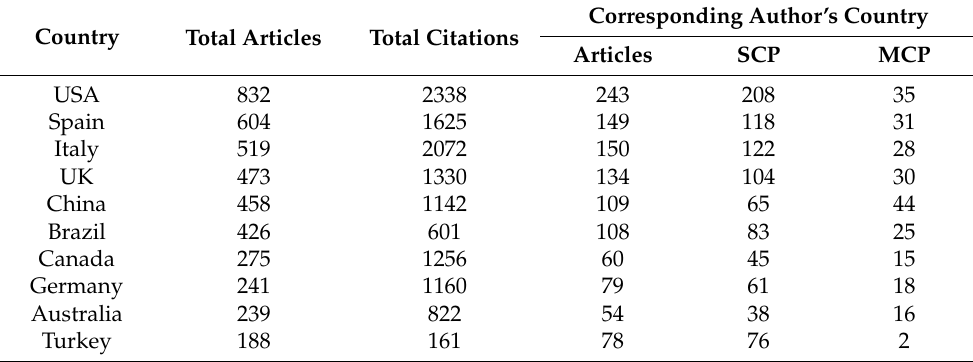
Table 4. Top 10 countries with the highest level of scientific production in physical activity and coronavirus disease (2020–2021).